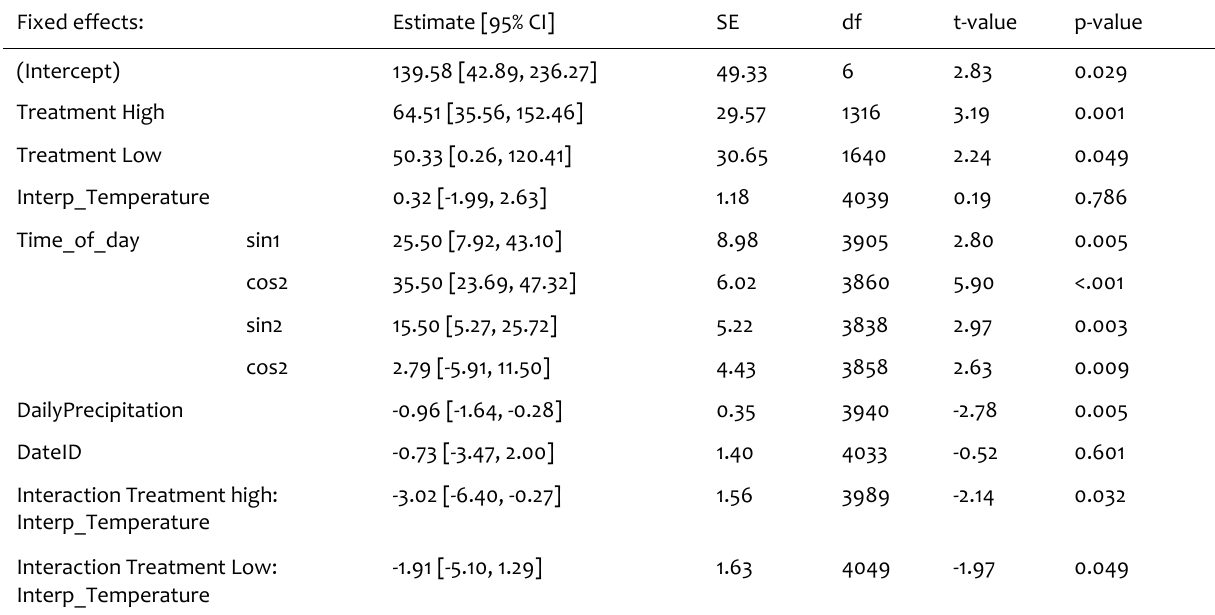
Table V. Generalized linear mixed-effects model (GLMM) for the effects of clothianidin exposure and abiotic factors on foraging bout duration in bumblebees with replicate, colony and individual bees as random